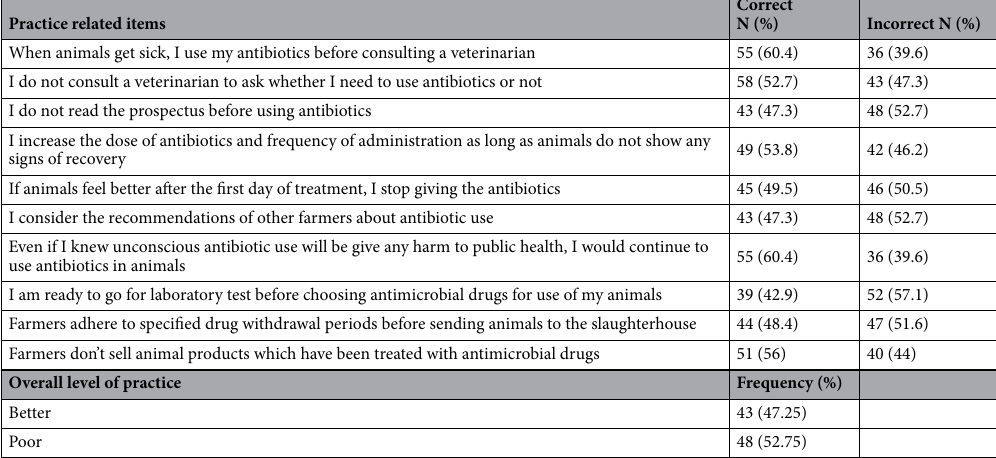
Table 7. Practice of animal farm owners/workers towards antimicrobial resistances and use in Amhara regional state, North Western Ethiopia (N = 91).